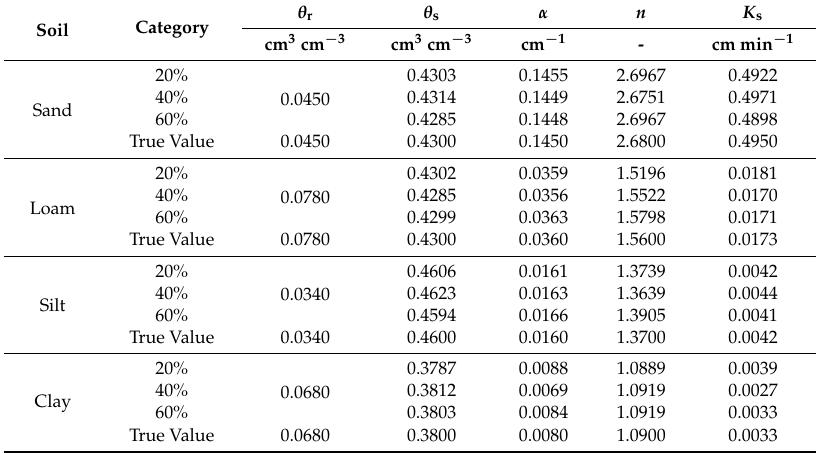
Table 3. Estimated parameters under three initial water content levels for four types of